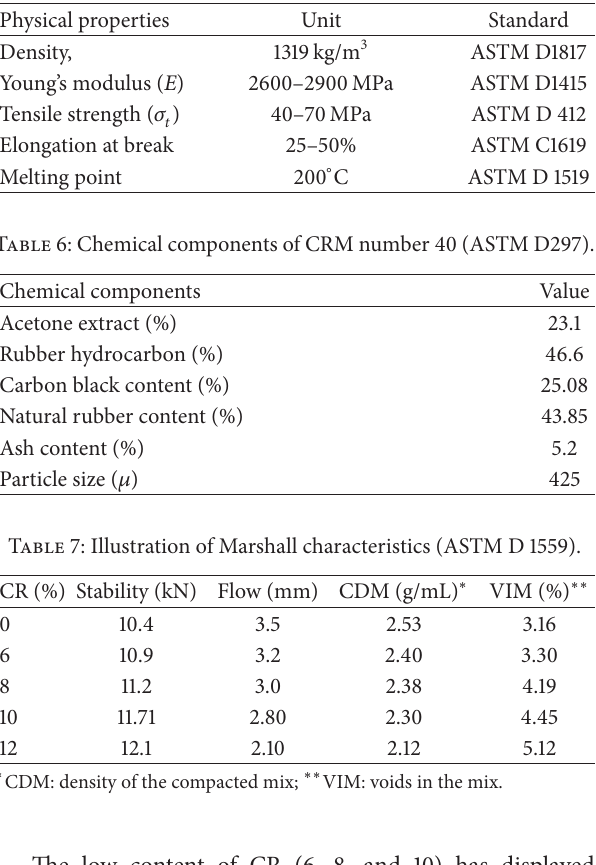
Table 5: The physical properties of crumb rubber (CR).